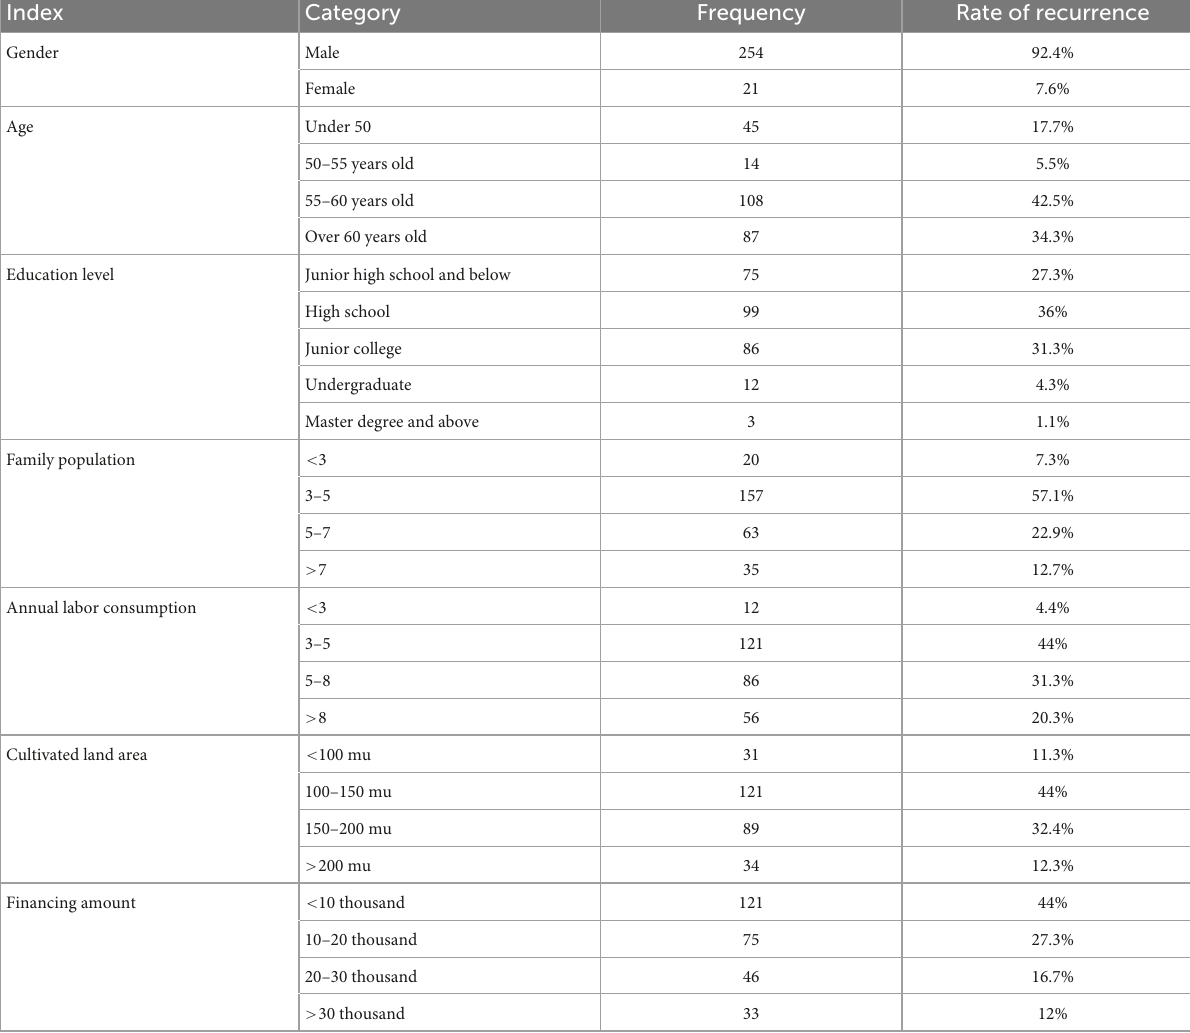
TABLE 1 Investigation of sample essential